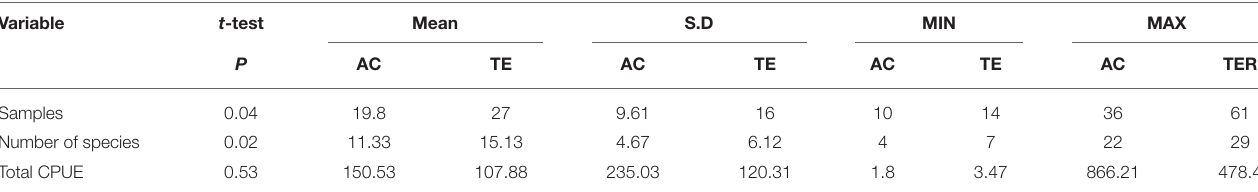
TABLE 3 | A t -test comparison (mean, minimum and maximum values, and S.D.) of the variables (number of samples, number of species, and catch per unit effort, CPUE) in the Tramandaí River estuary (TRE) and marine adjacent coastal area (AC). Variable t -test Mean S.D MIN MAX P TER Samples